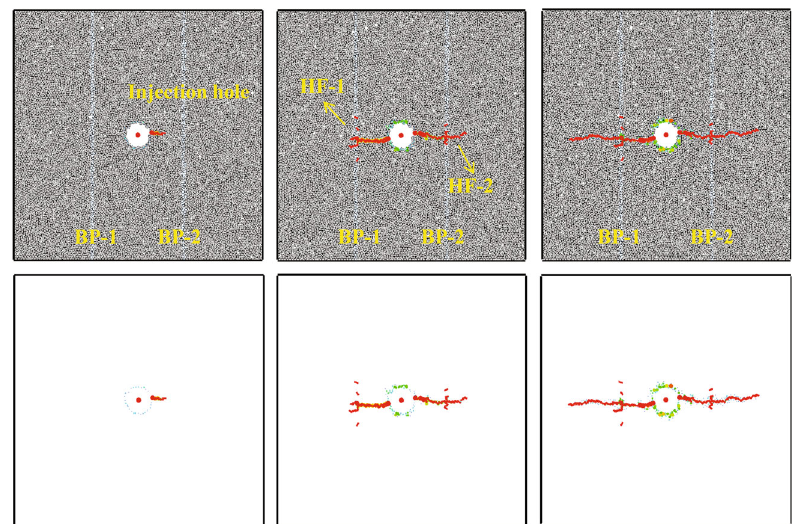
Figure 7: Group 1-1 hydraulic fracture morphology and interactive penetration mode.